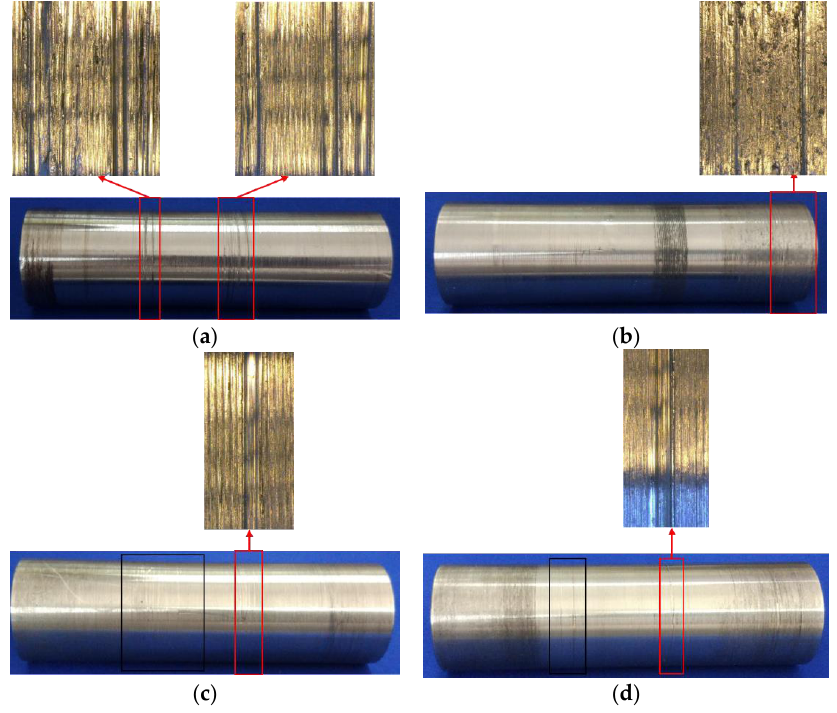
Figure 6. Worn micrographs of four specimens: ( a ) the first specimen; ( b ) the second specimen; ( c ) the third specimen; ( d ) the fourth